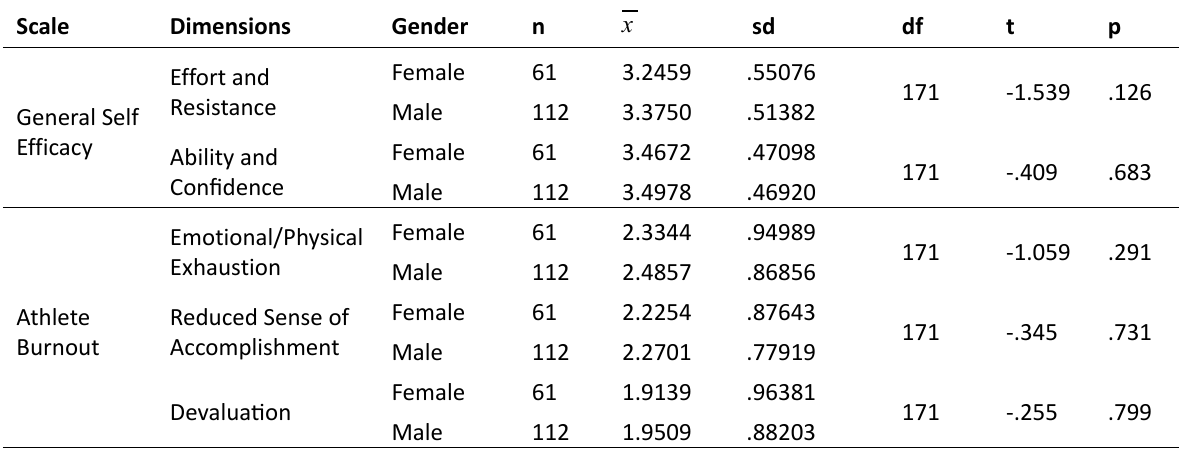
Table 2. Evaluation of general self-efficacy and athlete burnout level by gender.